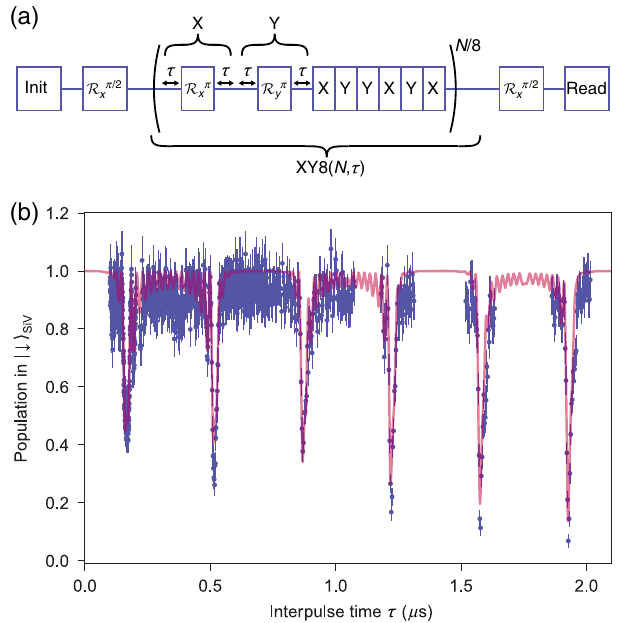
FIG. 2. Nuclear spin resonance spectroscopy using an XY8 decoupling sequence on the SiV spin. (a) Schematic of the XY8 sequence. Here, R θ x ( R θ y ) represents a pulse that rotates the SiV spin by an angle θ around the X ( Y ) axis of the Bloch sphere. Note that “ init ” and “ read ” represent optical initialization and readout, respectively, and N is the total number of π pulses. (b) Meas- urement of the final SiV spin population in j ↓ i for an XY8 sequence with N ¼ 16 pulses, as a function of the interpulse time τ . The blue dots correspond to the experimental data. The error bars represent the standard deviation of the measured SiV spin population, from photon counting statistics [34]. A fit (red curve) to the data yields the hyperfine coupling parameters f A ¼ k 0 . 33 MHz g for the target nuclear spin 0 . 11 MHz ; A ⊥ ¼